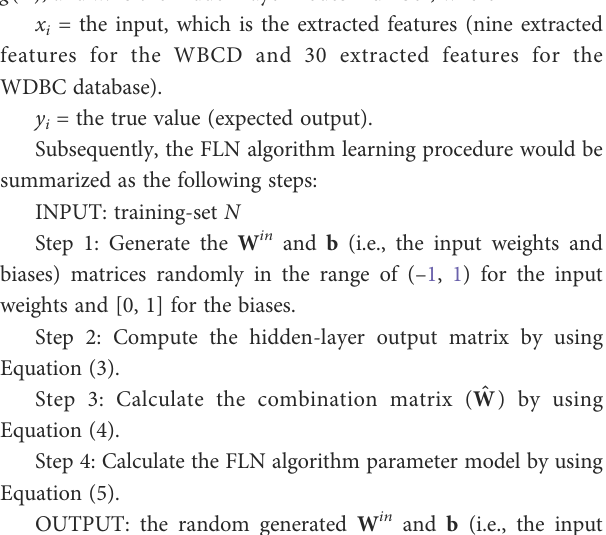
FIGURE 3 The FLN algorithm